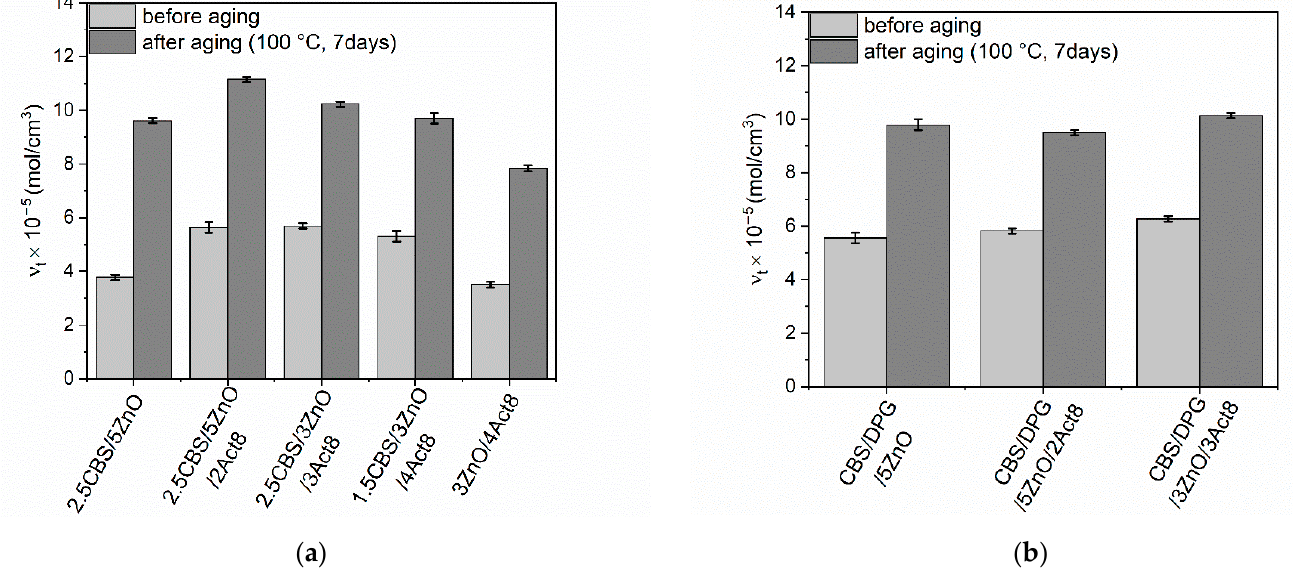
Figure 5. Influence of thermo-oxidative aging on the crosslink density of SBR vulcanizates containing: ( a ) CBS; ( b ) CBS and DPG.